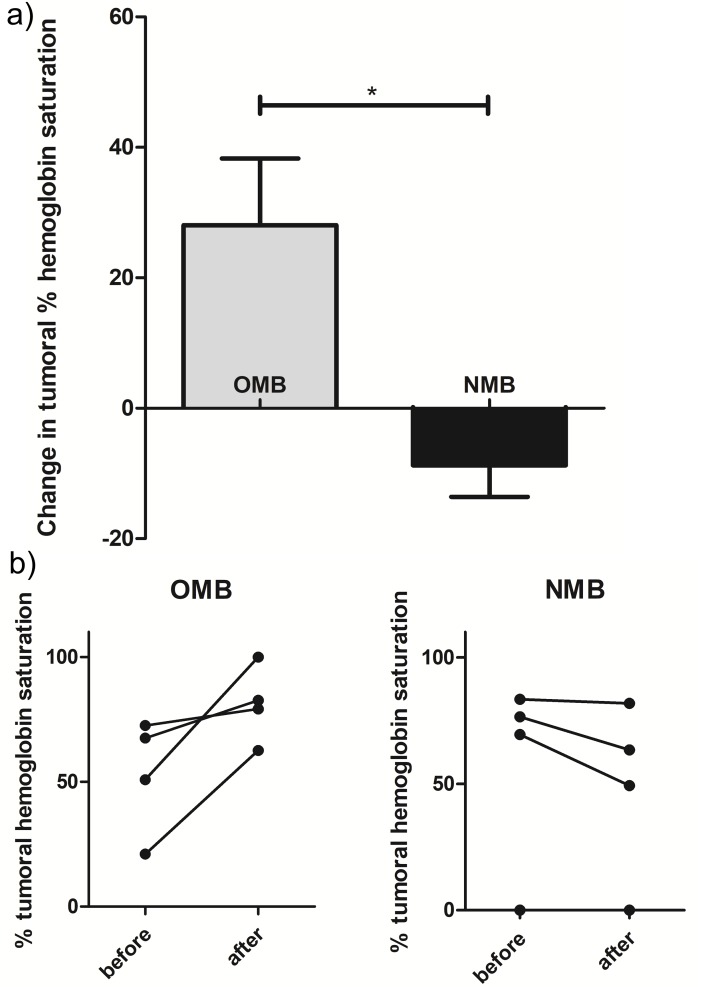
Change in tumoral oxygenation with intra-tumoral injection of OMB or NMB.The time to peak was found to be 97 s after injection on average, and the OMB-induced increase in tumoral oxygenation lasted for over 18 min on average (our protocol’s maximum 1 h experiment time meant that we could not wait for a complete return to baseline in some cases). A) Average peak change in tumoral hemoglobin saturation after OMB or NMB administration (n = 4/group). B) Individual data points showing pre- and post-injection values. This demonstrates baseline hypoxia in all tumors (0–83% hemoglobin saturation across all 8 tumors).